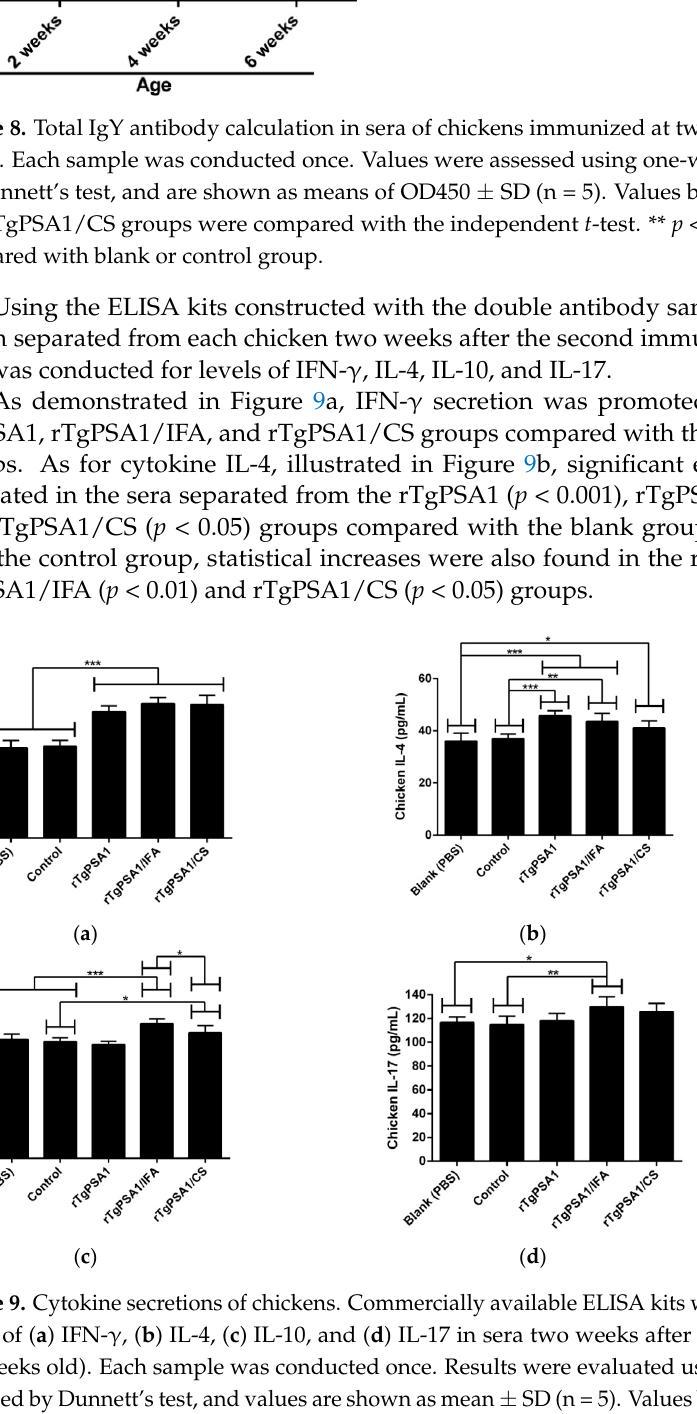
Figure 9. Cytokine secretions of chickens. Commercially available ELISA kits were used to determine levels of ( a ) IFN- γ , ( b ) IL-4, ( c ) IL-10, and ( d ) IL-17 in sera two weeks after second immunization (six weeks old). Each sample was con- ducted once. Results were evaluated using one-way ANOVA followed by Dunnett’s test, and values are shown as mean ± SD (n = 5). Values between rTgPSA1/IFA and rTgPSA1/CS groups were compared with the independent t -test. * p < 0.05, ** p < 0.01, and *** p < 0.001 compared with blank or control